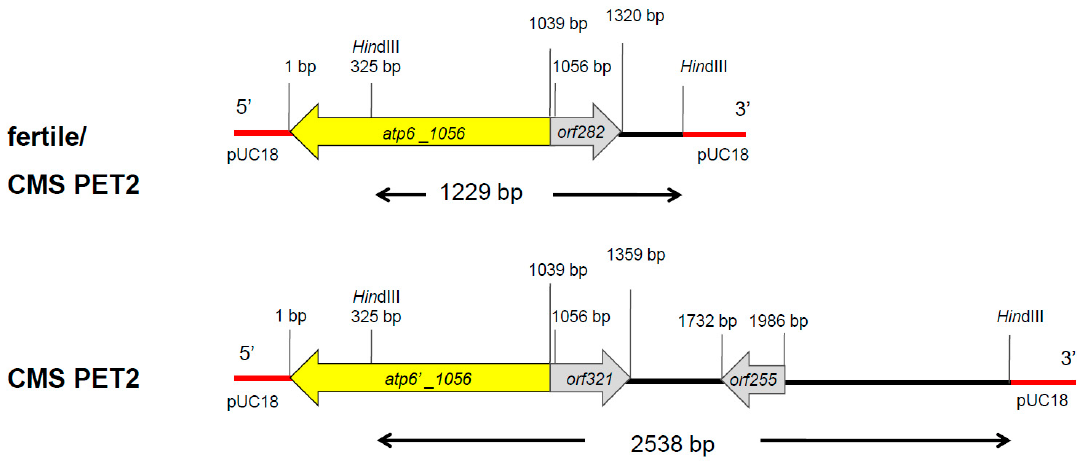
Figure 3. Comparison of the organization of the open reading frames on the hybridization fragments obtained by using atp6 as probe in the normal, fertile HA89 and CMS PET2.